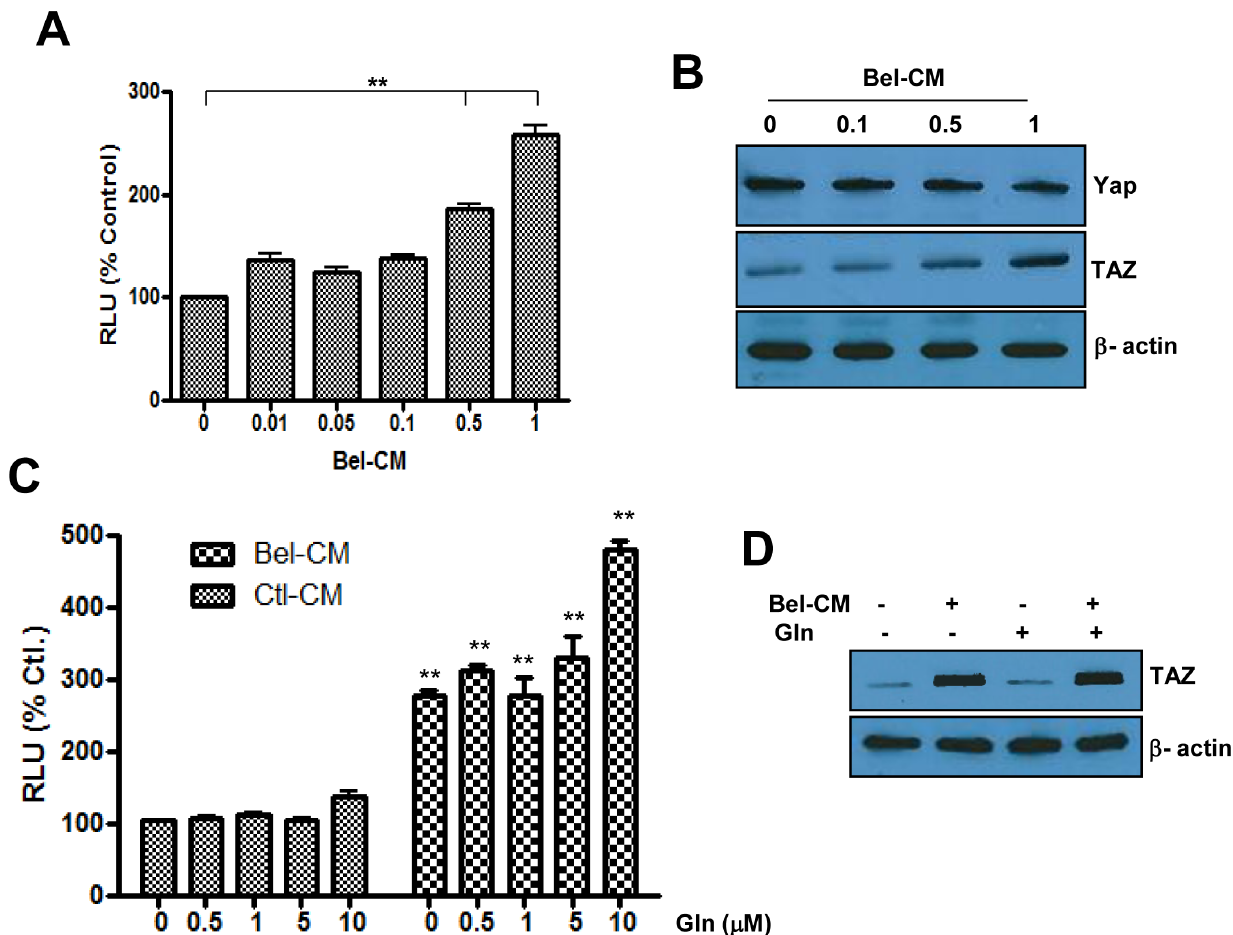
Figure 4. Potential role of G-protein coupled receptors in mediating Belinostat induced activation of the Hippo pathway. Panel A. Effect of conditioned medium from Belinostat pre-exposed cells on activation of the Hippo reporter in naı¨ve cells (not previously exposed to the drug). SW480 cells were incubated with Belinostat at the indicated concentrations for 24 hours, the drug was then washed extensively and the cells incubated with fresh media for 24 hrs. The resulting conditioned media (CM) were then incubated for 24 hrs with naı¨ve cells transfected with the Hippo luciferase reporter, after what the activity of the enzyme was determined. The data represent average of three determinations 6 SE. Statistical significance is shown for Bel-CM-exposed cells compared to the control (**p , 0.001). Panel B. Representative Western blots showing the effect of CM from Belinostat treated cells on expression of YAP and TAZ in naı¨ve cells. Beta actin was used as a loading control. Panel C. Effect of glucagon (Gln), a GPCR antagonist, on Bel-CM induced activation of the Hippo reporter. SW480 cells transfected with the luciferase reporter were incubated in the absence or the presence of CM from cells pre-exposed to 0.5 m M Belinostat (Bel-CM), and in the absence or the presence of glucagon at the indicated concentrations. Luciferase activity was measured after 24 hrs of incubation. The data represent average of three determinations 6 SE. For every Gln concentration, values were compared between Bel-CM exposed cells and those exposed to control CM (**p , 0.001). Panel D. Effect of Glucagon on Belinostat-mediated increase in TAZ levels determined by western blot in cells exposed or not to Bel-CM and in the absence or presence of Gln at 5 m M. Staining with beta actin represents a loading control.